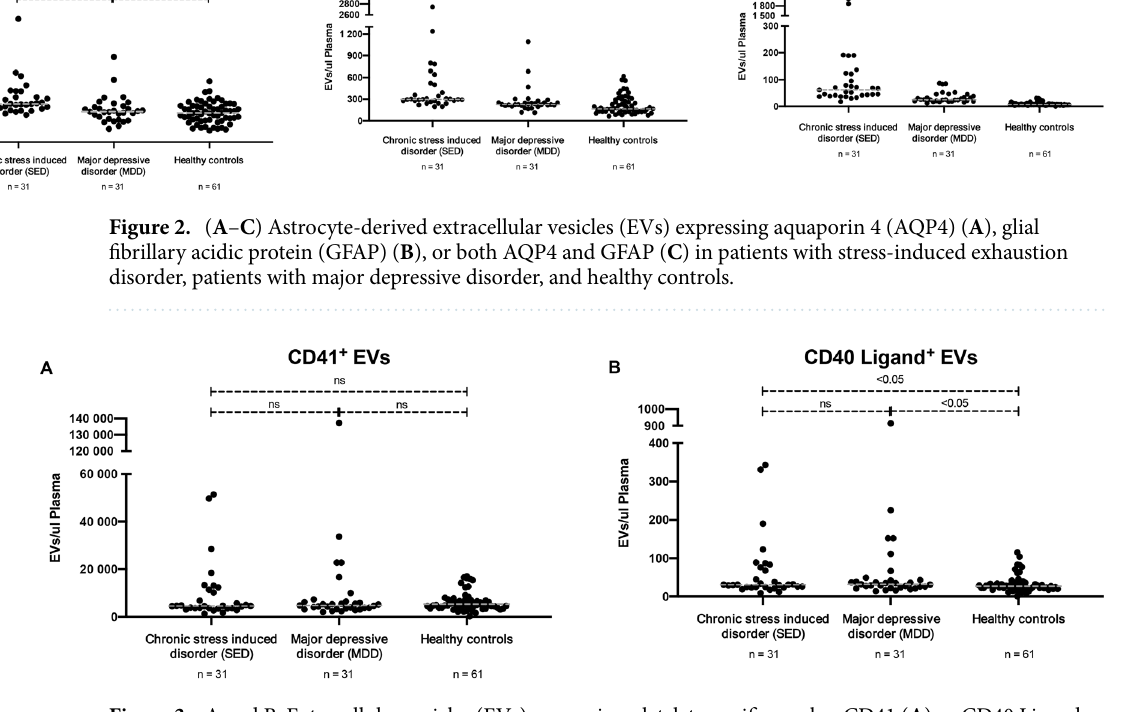
Figure 3. A and B. Extracellular vesicles (EVs) expressing platelet-specific marker CD41 ( A ) or CD40 Ligand ( B ) in patients with stress-induced exhaustion disorder, patients with major depressive disorder, and healthy